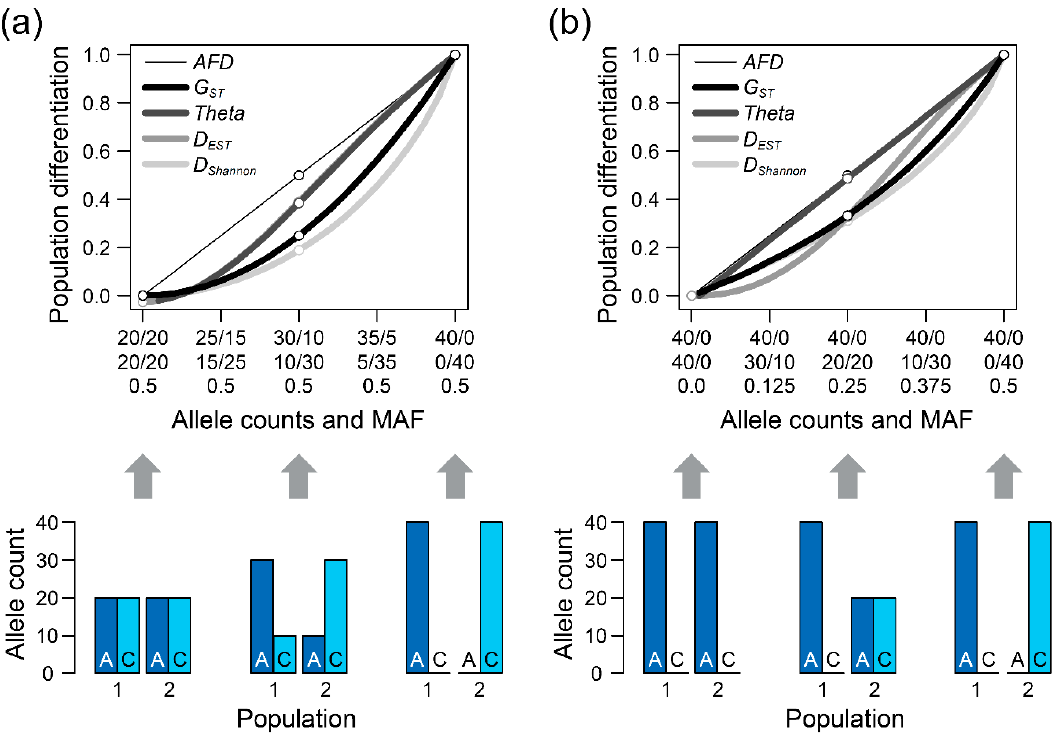
Figure 1. Population differentiation expressed by different metrics, including re-calculated Shannon differentiation ( D Shannon ). G ST and Theta were calculated according to the formulas (8) and (6) provided in Reference [28] in the paper. D EST was calculated using formula (13) in Reference [14]. All graphing conventions follow Figure 1 in the paper.